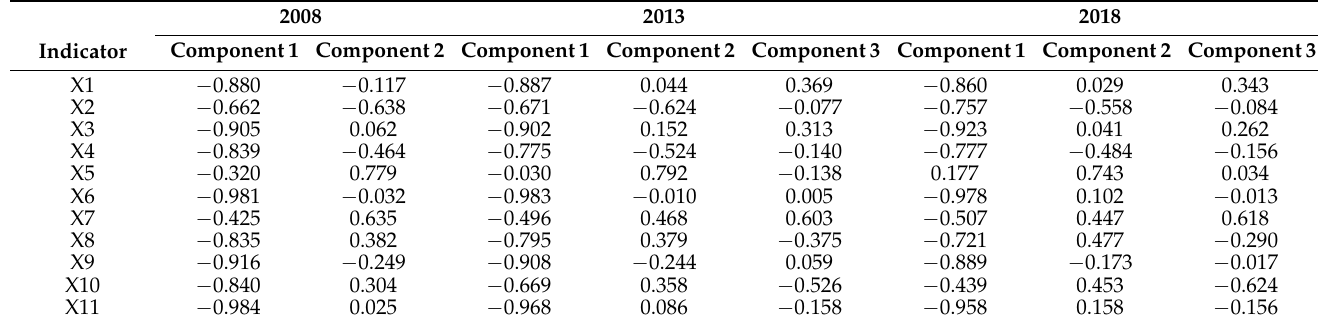
Table 9. Value of the principal component